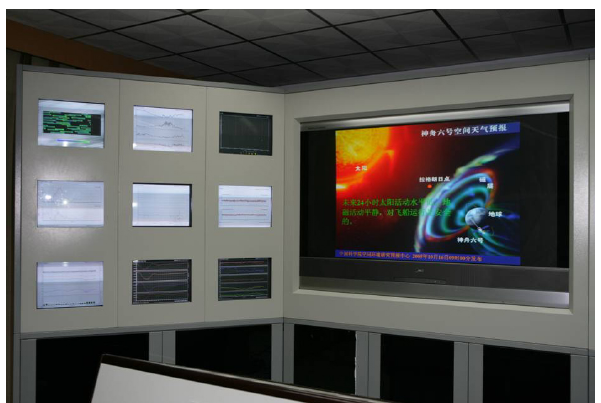
Figure 5. Space weather prediction service at SEPC of RWC-China for the Chinese Shenzhou VI manned space flight mission in Octo- ber